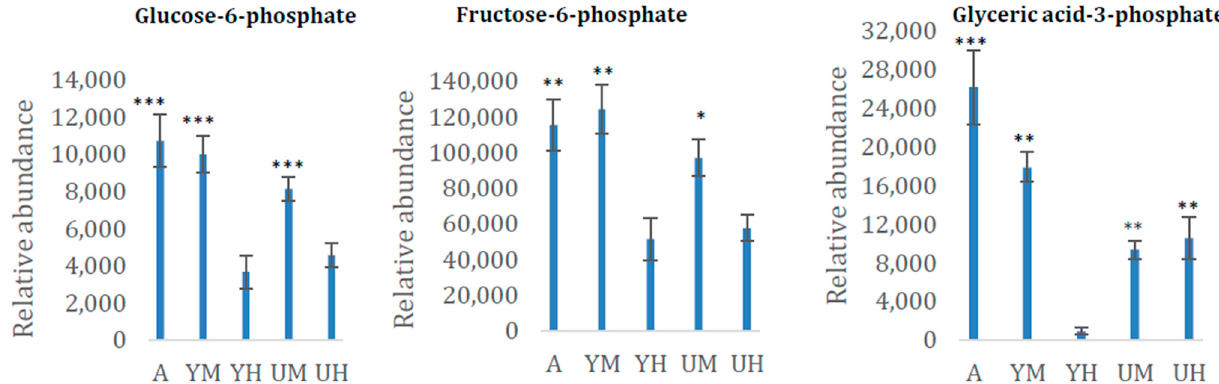
Figure 3. Relative content of three key carbon metabolism intermediates (means ± standard deviations, n = 8) in the Chlorella cultures after 8 days of cultivation in the following conditions: autotrophic (AUTO), mixotrophic with glycerol (GLY MIXO), heterotrophic with glycerol (GLY HETE), mixotrophic with glucose (GLU MIXO), heterotrophic with glucose (GLU HETE). *, **, and *** indicate significant differences in concentration relative to cultures grown in heterotrophic conditions with glycerol according to Student’s t -test at p < 0.05, 0.01, and 0.001, respectively.